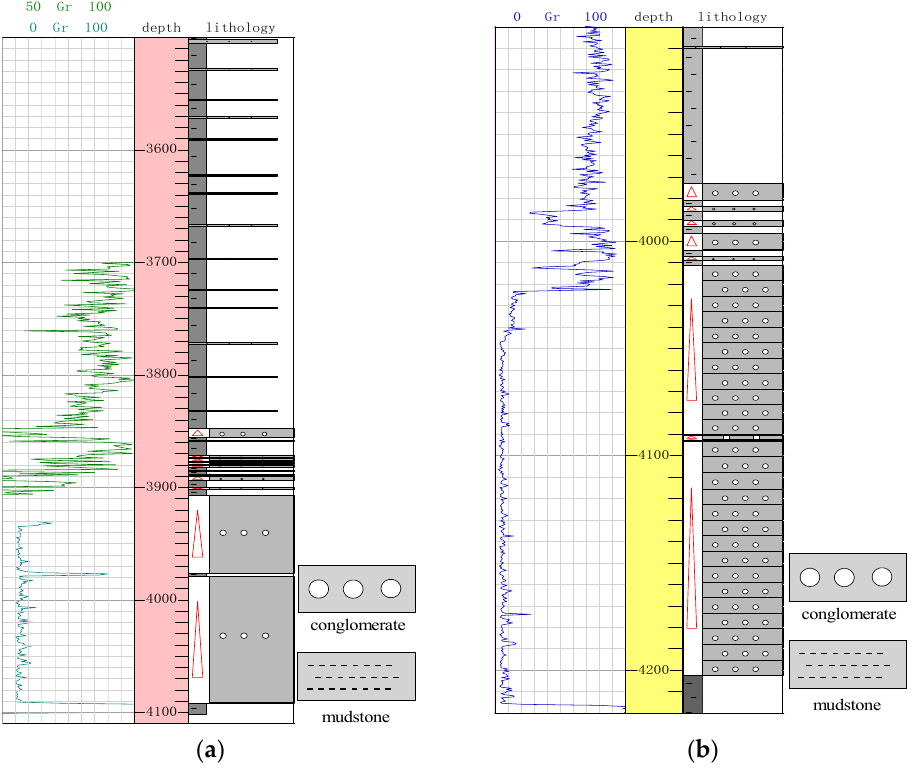
Figure 5. Drilling column diagram of a main producing layer of X9: ( a ) Well X9-2x; ( b ) Well X9-9X.